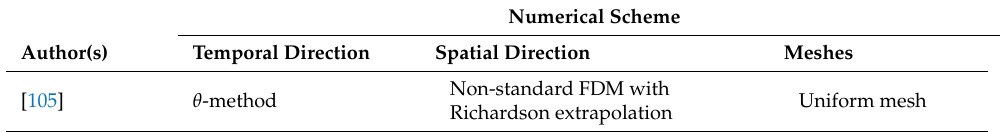
Table 14. Various methods and mesh used to solve Equations (21) and (22).